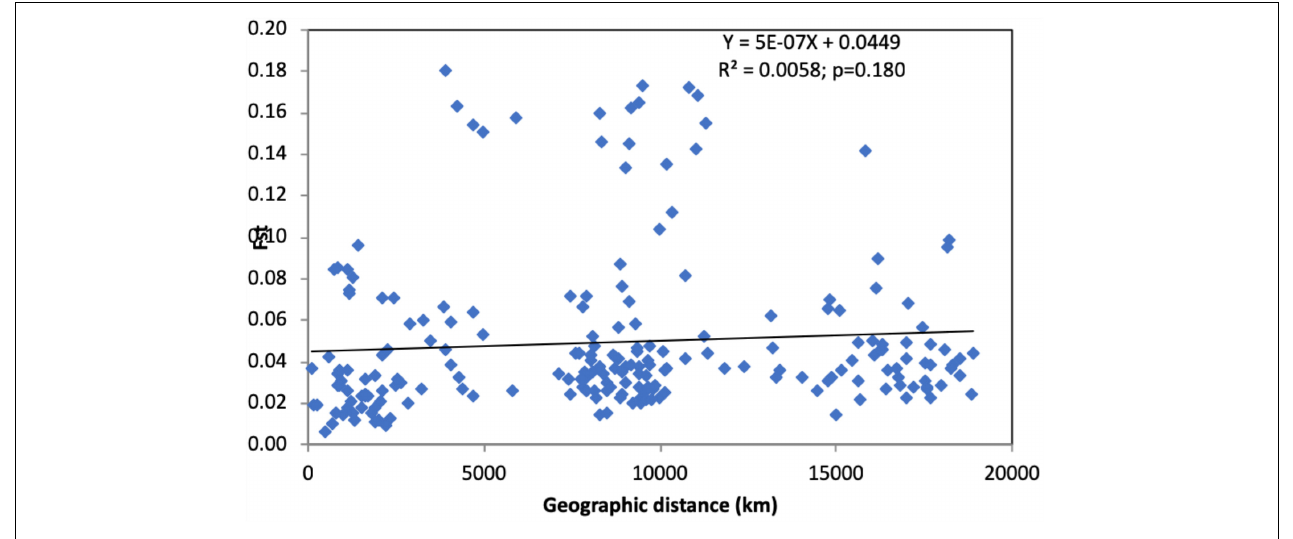
FIGURE 1 | The relationship between genetic differentiation and geographic distance between pairs of regional and national samples of Candida tropicalis . Only regional or national samples with sample sizes greater than 10 were included in this analysis. X -axis: geographic distance, Y -axis: pairwise F ST values. No statistically significant correlation was observed between geographic distance and genetic difference in the global sample of C. tropicalis ( p =